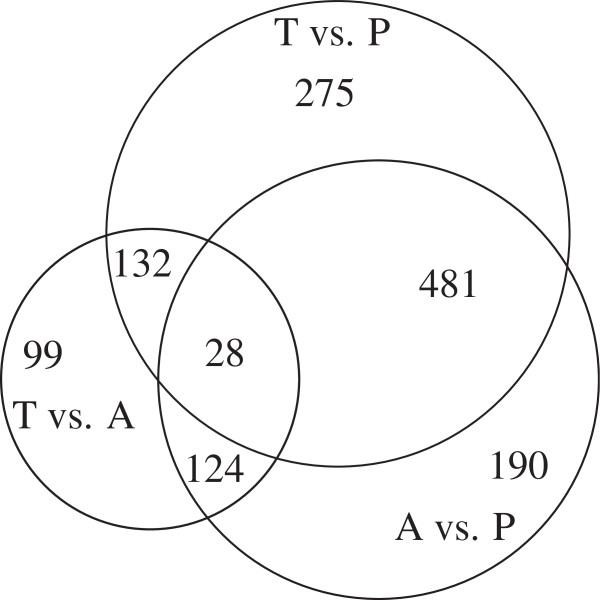
Venn diagram of differentially expressed genes during hibernation. 916, 823, and 383 genes were differentially expressed in T vs. P, A vs. P, and T vs. A comparisons, respectively. T: torpor; A: arousal episodes; P: post-reproduction.